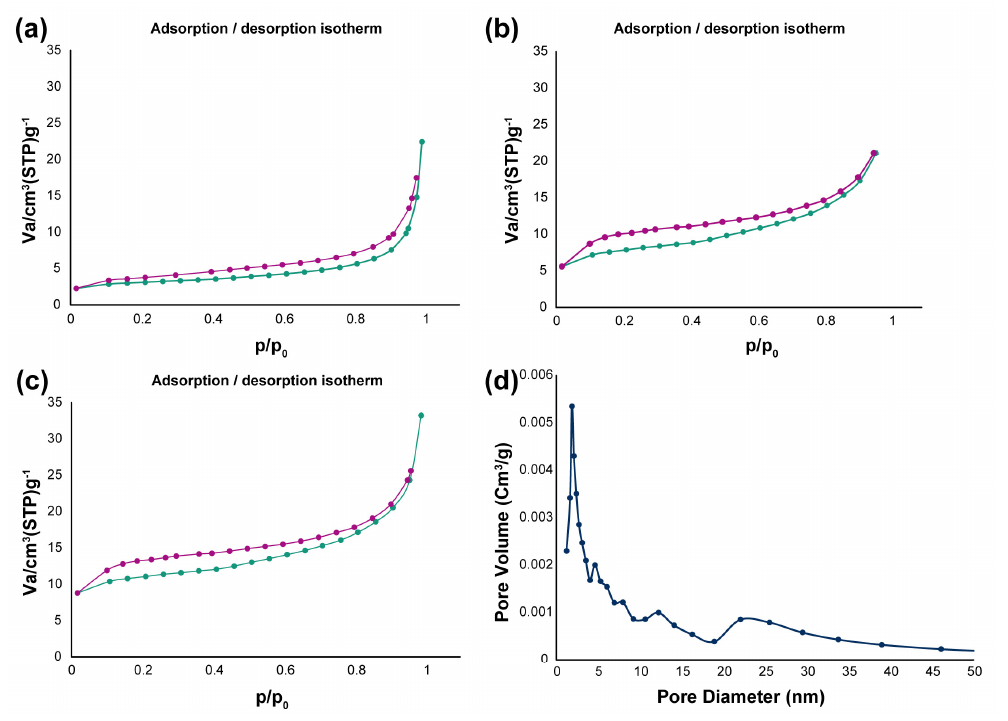
Figure 4. BET surface area of ( a ) CdS, ( b ) CdS / Ag 3 PO 4 , and ( c ) Pt-Ag 3 PO 4 / CdS / chitosan. ( d ) Pore size distribution plot (BJH plot) of Pt-Ag 3 PO 4 / CdS /